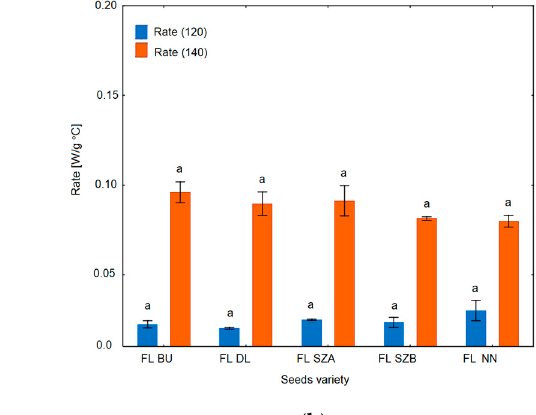
Figure 3. DSC isothermal oxidation curves obtained at 120 °C for cold ‐ pressed flaxseed oils.